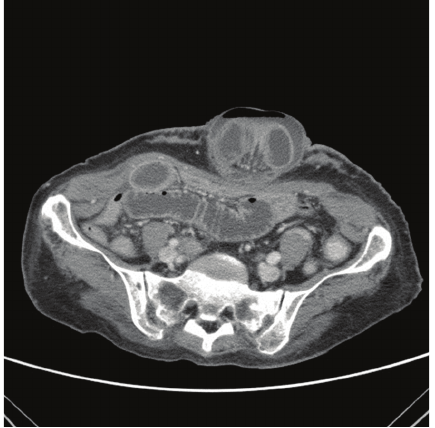
Figure 1: Umbilical hernia with dilated small bowel loop within and proximal to the hernia